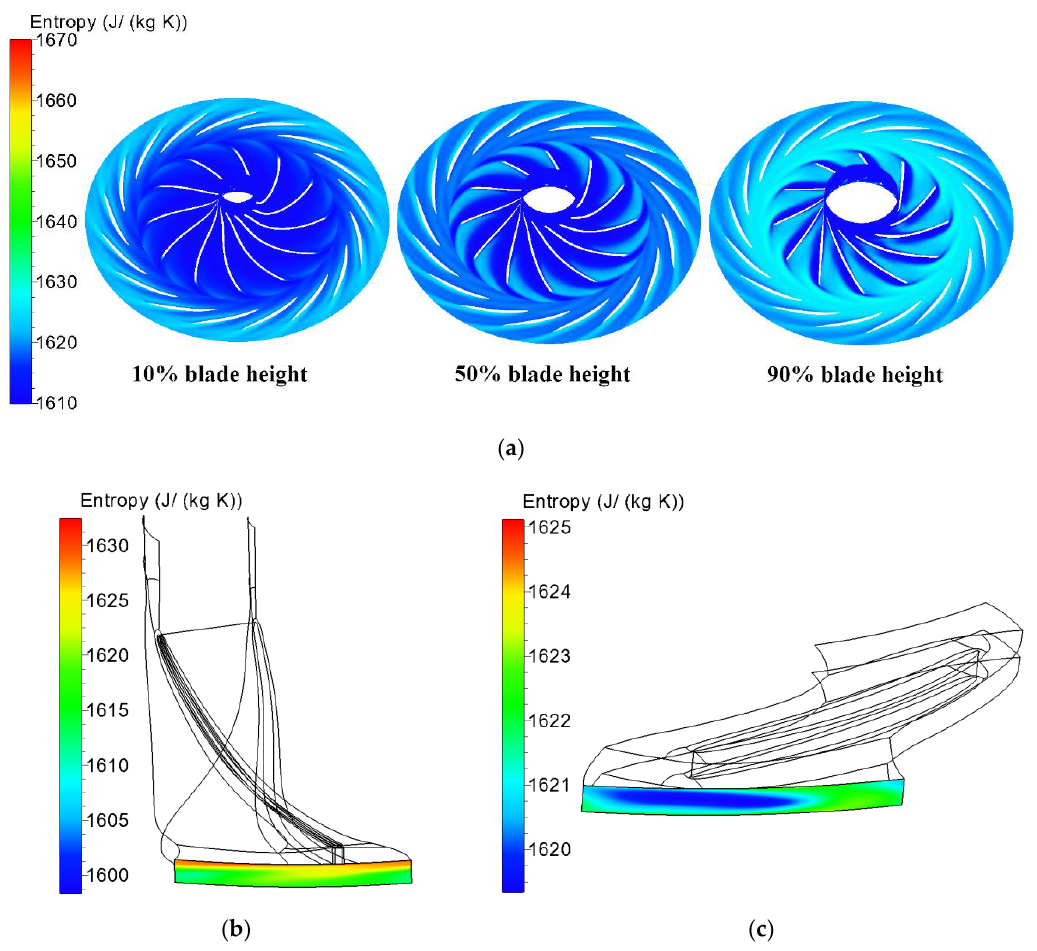
Figure 19. The entropy distribution of different sections: ( a ) different blade height sections; ( b ) impeller outlet and ( c ) diffuser outlet.